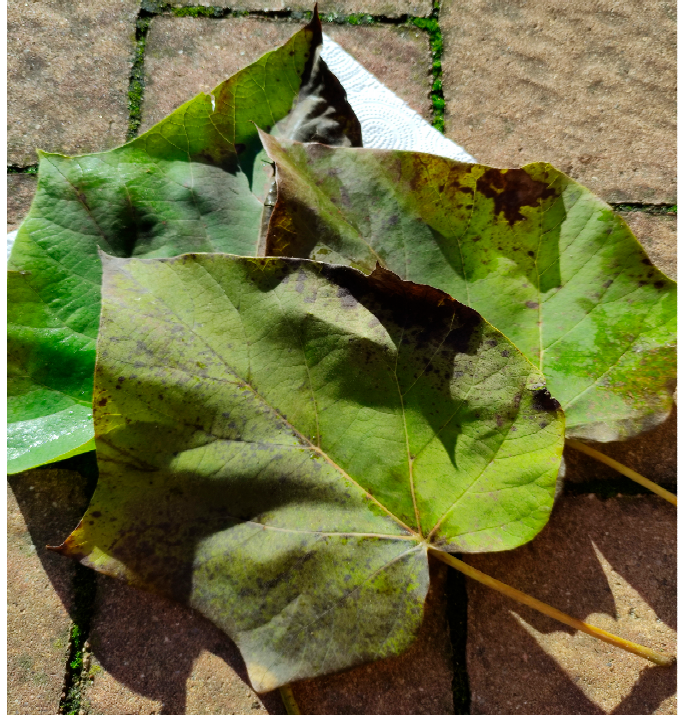
Figure 3. Pictures of leaves from the harvest “Fresh fallen”.